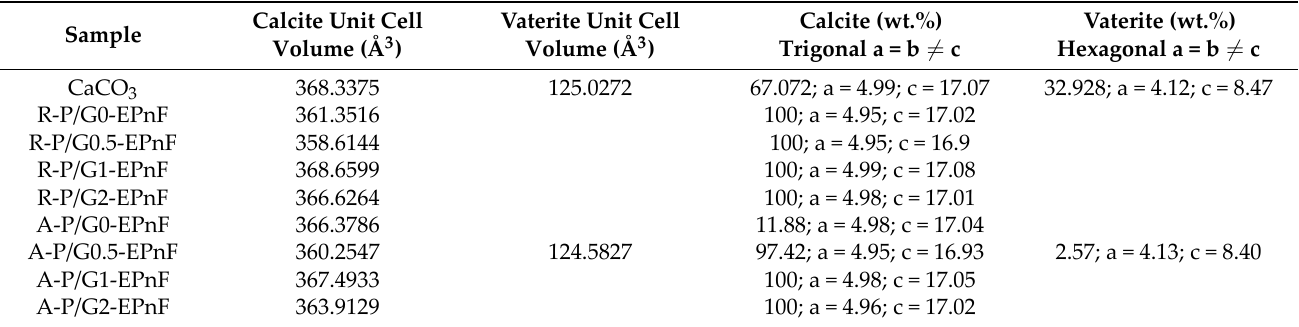
Table 4. Unit cell volume and quantitative analysis of crystal structure and phase of CaCO 3